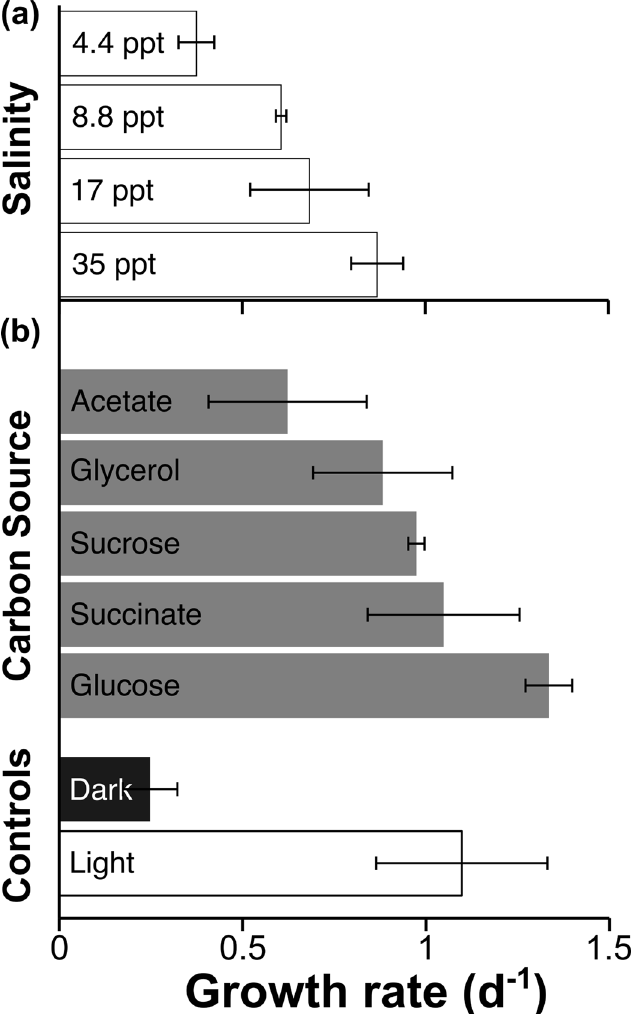
growth with a PPFD of 80 μ mol photons m − 2 s − 1 ; gray bars indicate grown in the dark plus a carbon source at a final concentration of 20 mmol L − 1 ; the black bar indicates growth in the dark. Values are the means of triplicate biological replicates (n = 3); error bars represent ± 1 standard error (SE).